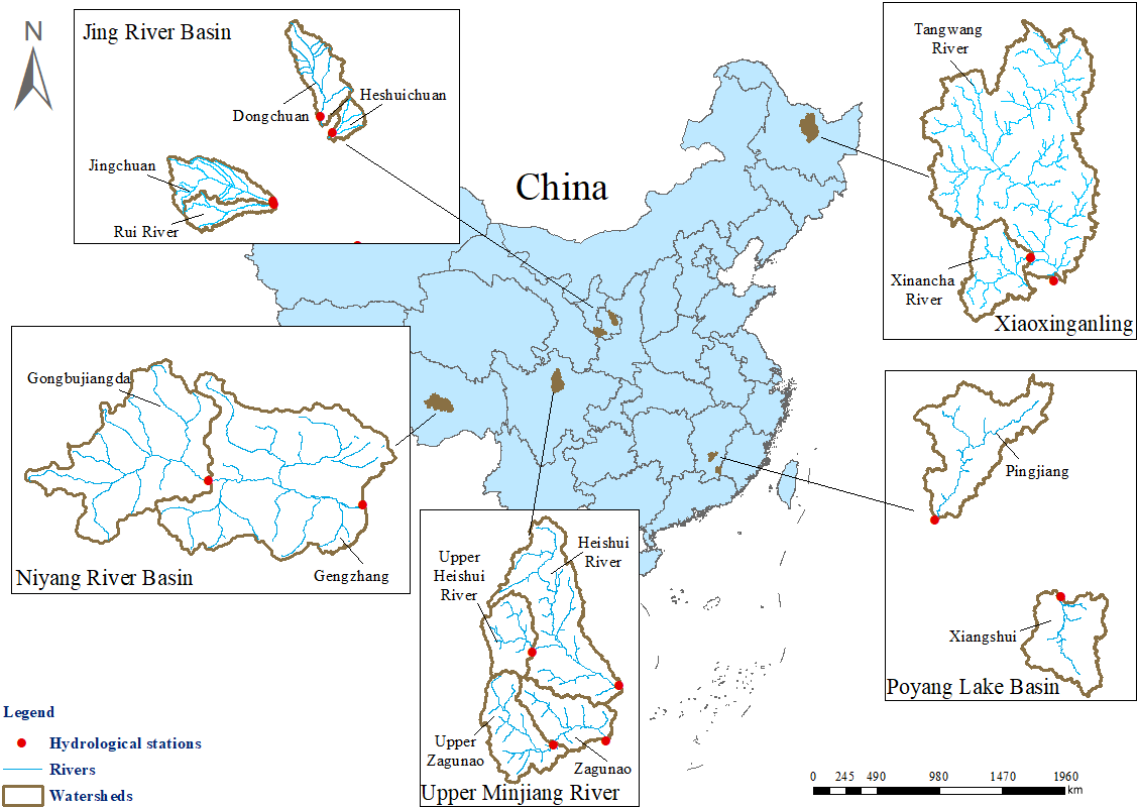
Figure 1. Locations of the study